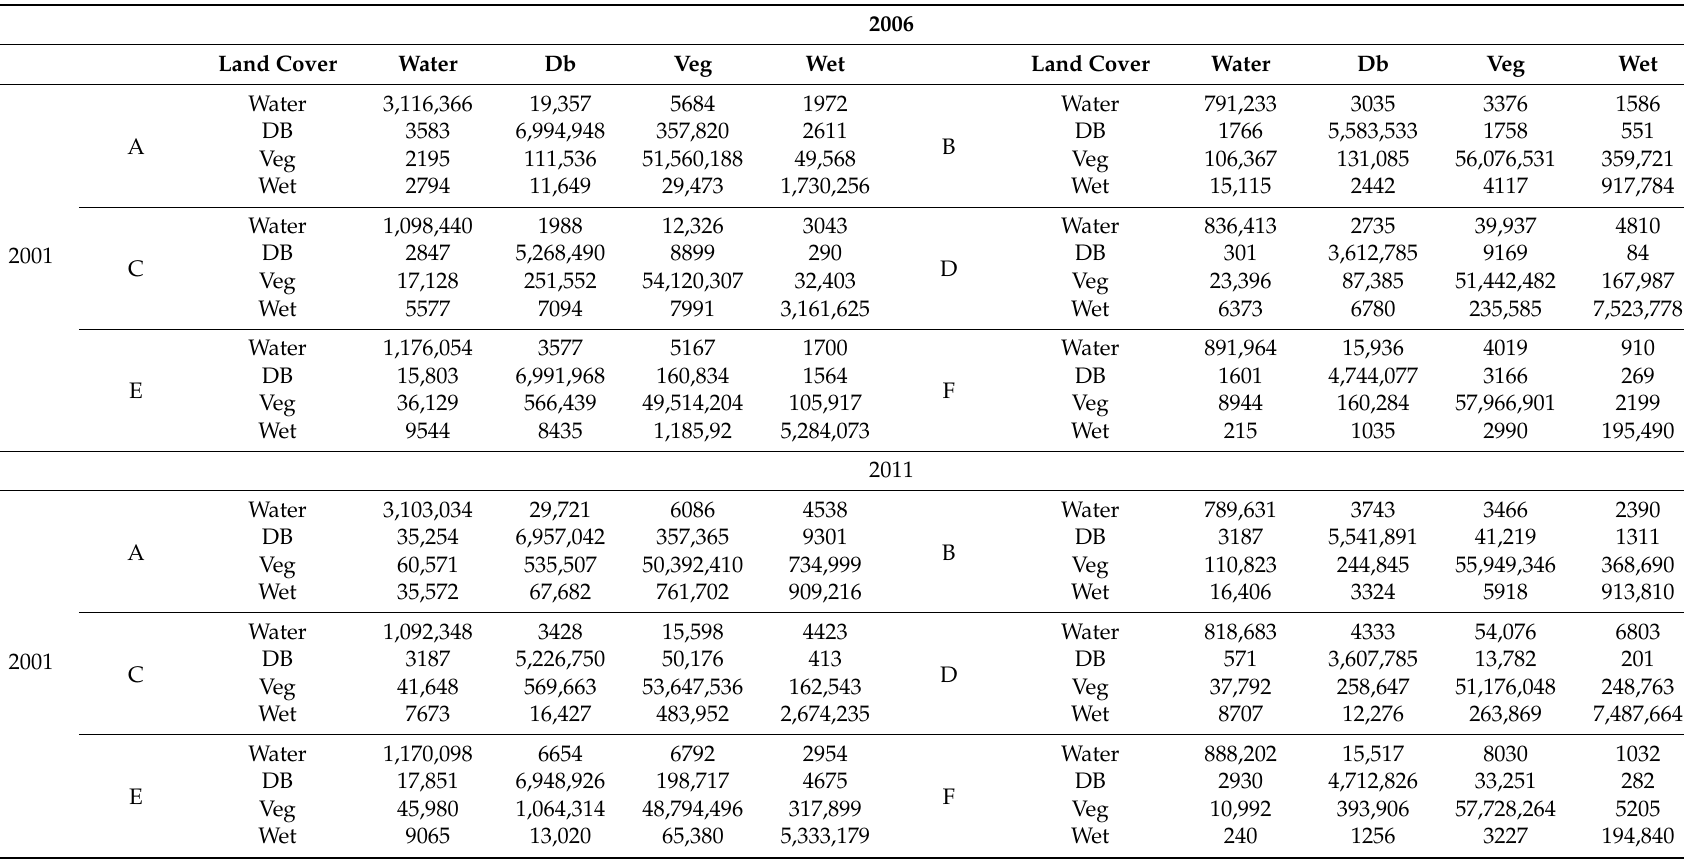
Table 4. Transfer matrixes for six study areas with the four-class scheme during 2001–2006 and